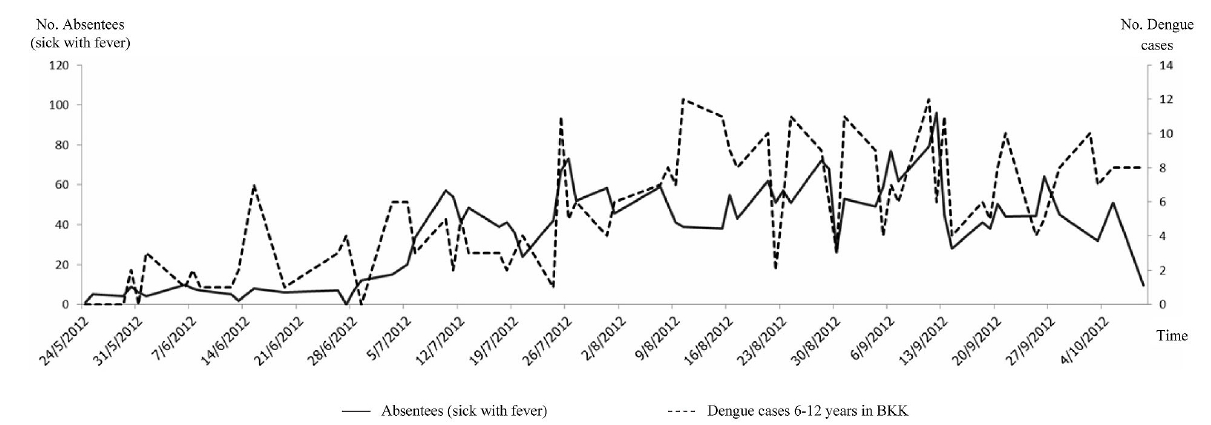
Figure 8. Patterns of daily number of school absentees (sick leave) and daily number of dengue cases during May 24 - October 9, 2012 (first semester).